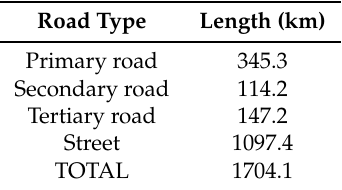
Table 1. Categories of roads considered in the study area.